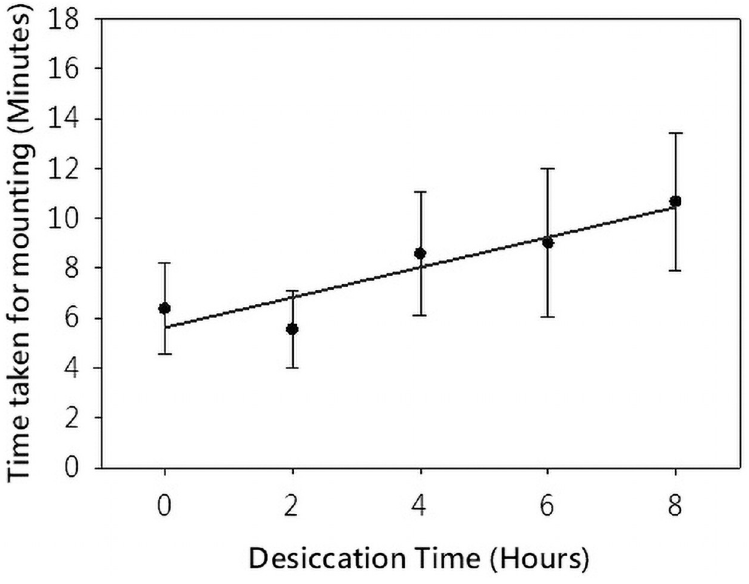
Fig 2. Desiccation time and mating latency. Desiccation time positively affected the time taken for mounting i.e. mating latency. Each data point denotes the average value recorded for 54 pairs, with the bars representing standard error values. P-value as per ANOVA: Single Factor test: